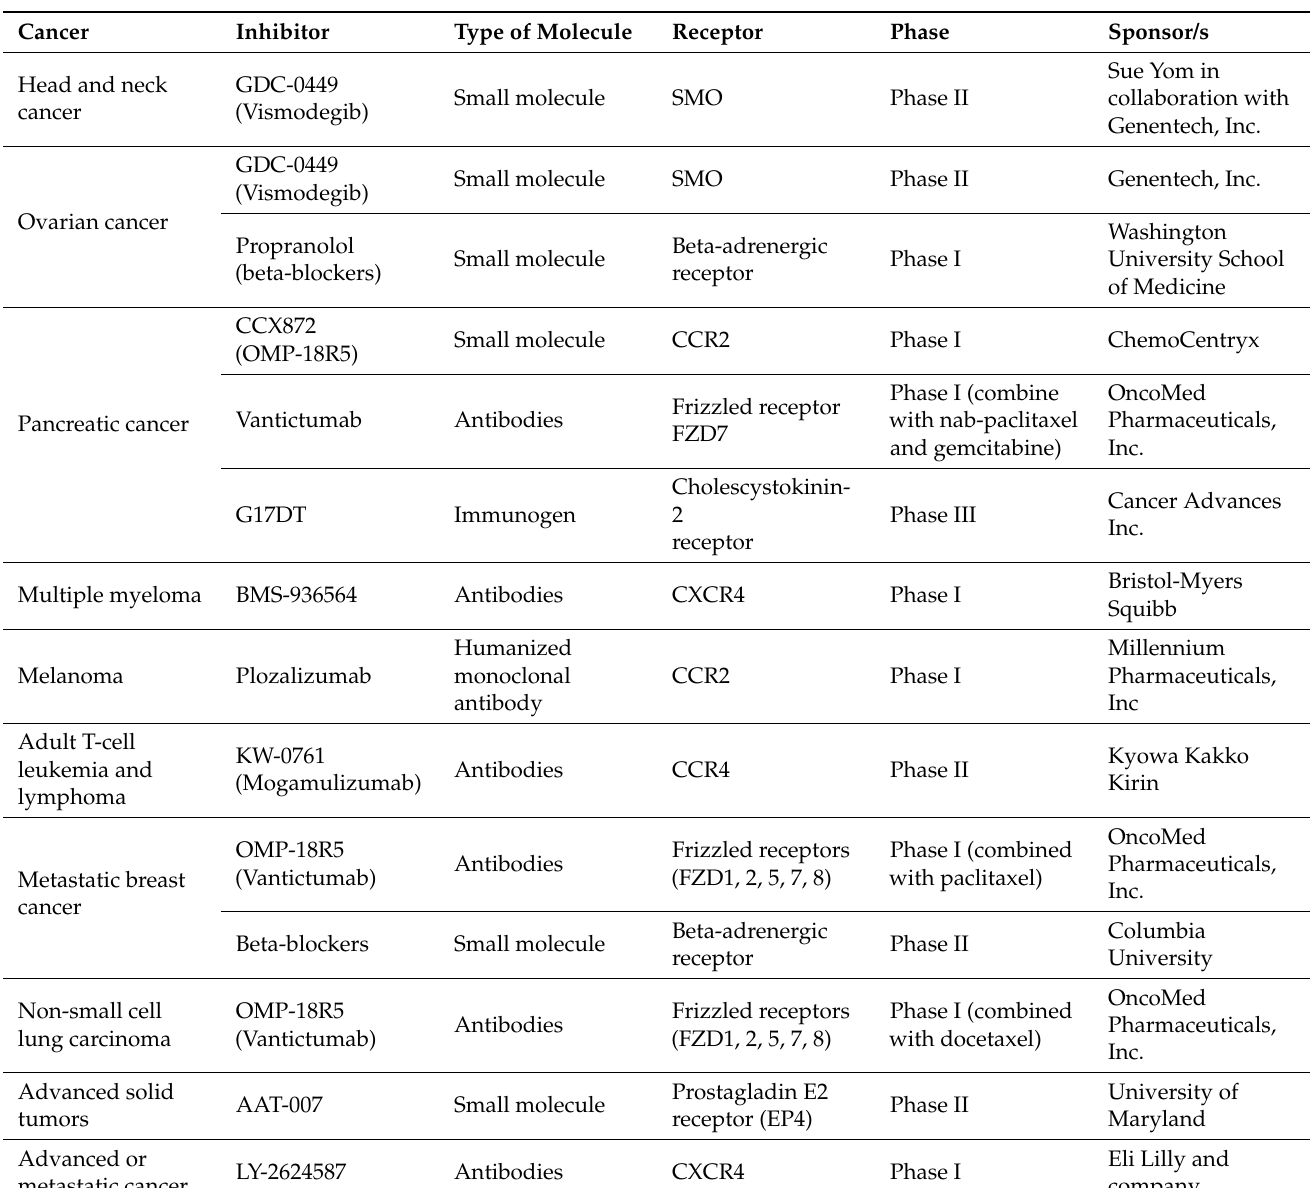
Table 4. Anti-GPCRs drugs and antibodies under clinical